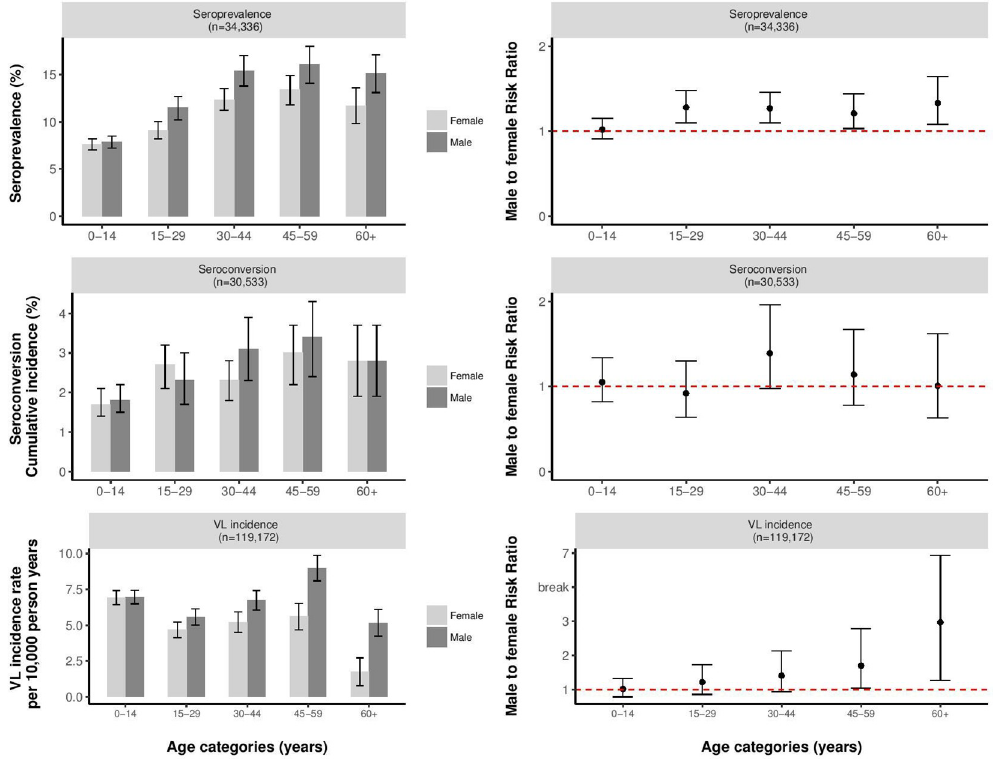
Fig 2. Seroprevalence (Direct Agglutination Test titer � 1:3,200), seroconversion rate as a cumulative incidence and visceral leishmaniasis incidence rate per 10,000 person years, are presented on the left panel of the figure per age group and including 95% confidence intervals. On the right panel of the figure the respective relative risks for males compared to females are represented by age group, including 95% confidence intervals. Seroprevalence figures are based on population- based longitudinal data of Kalanet (2006–2009; n = 13,286) and TMRC (2009–2010 (2012–2013 for ‘new area’); n = 21,050). Seroconversion figures are based on population longitudinal data, including individuals for whom at least two serological results were available from Kalanet (2006–2009; n = 12,537) and TMRC (2009–2010 (2012–2013 for ‘new area’); n = 17,996). VL incidence rates are based on population-based longitudinal data of Kalanet (2006–2009; n = 13,286) and TMRC (2007 (2012 for ‘new area’)– 2015; n =